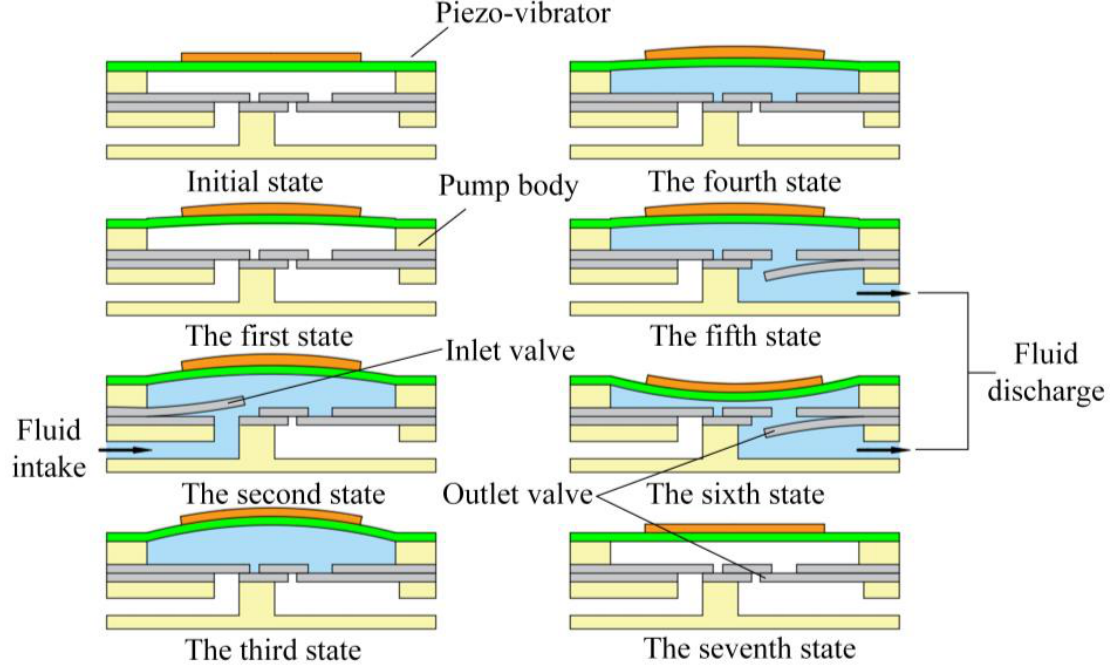
Figure 2. Schematic diagram of working state.